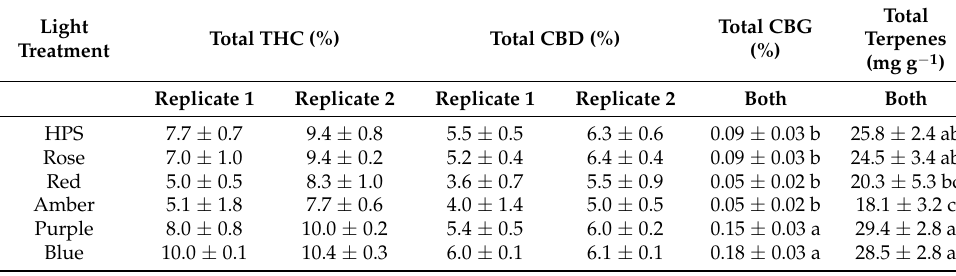
Total Total CBG Terpenes (%) (mg g − 1 )